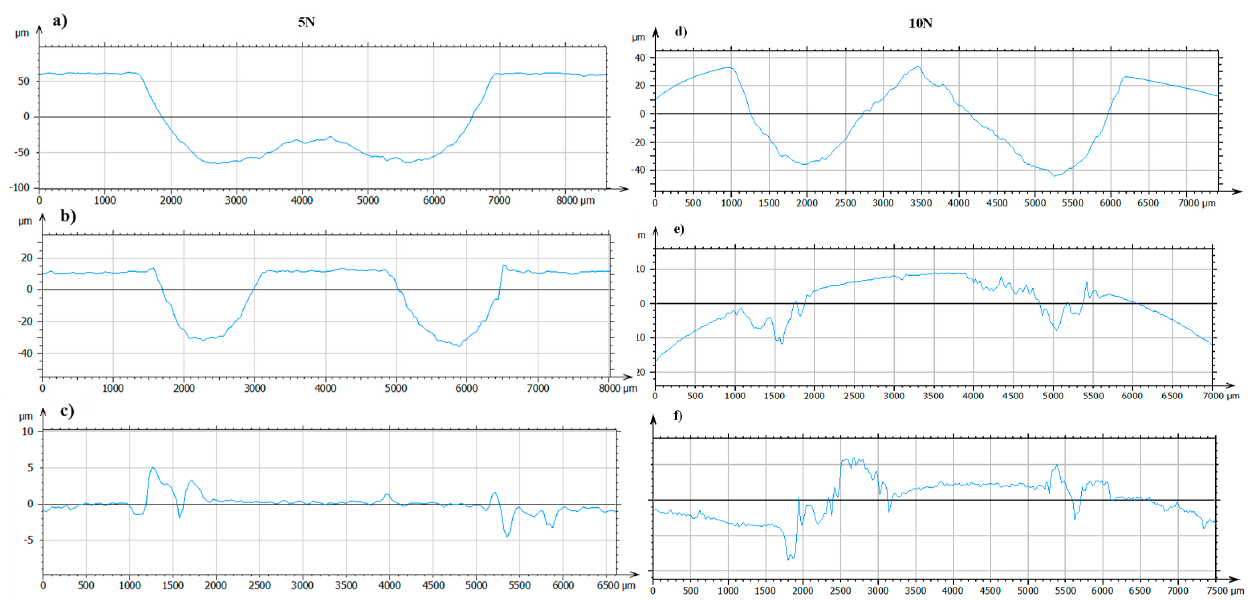
Figure 10. Profile of the worn surfaces obtained in the optical profilometer after a tribological test at 5 and 10 N, respectively, in ( a , d ) MM, ( b,e ) MMC and ( c , f ) MMC-T6.